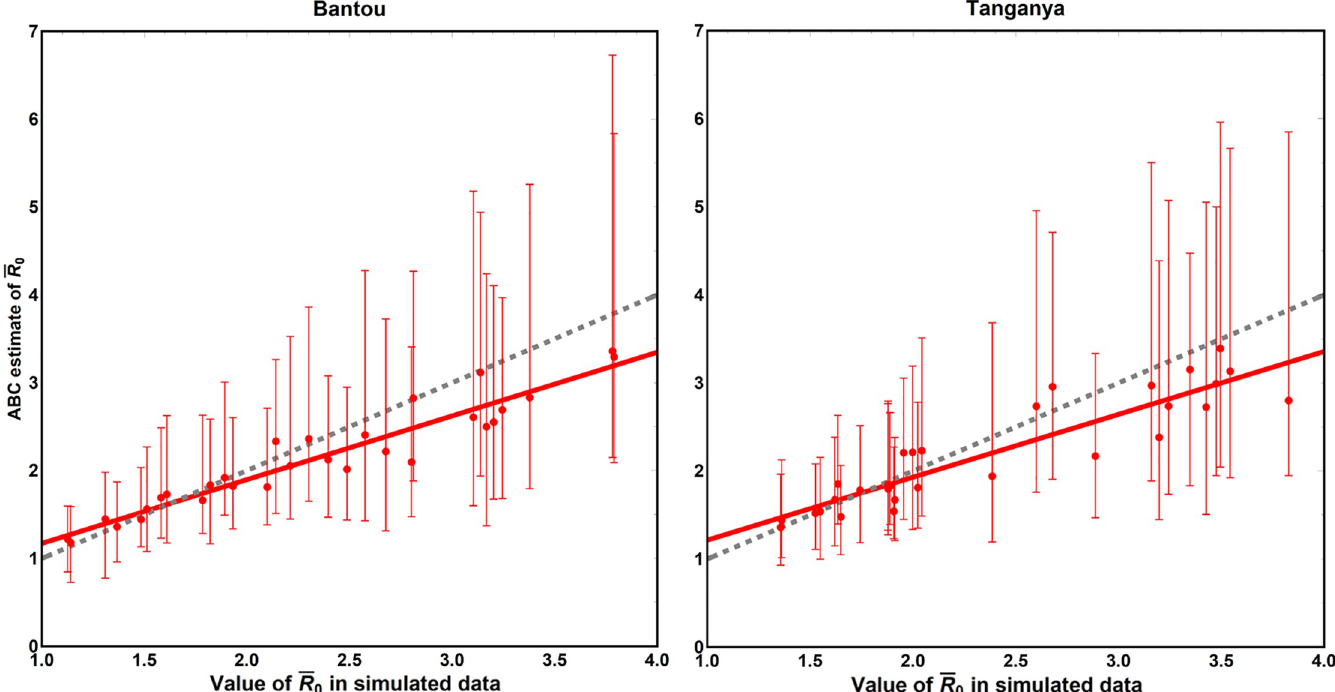
Fig 2. Comparison of time average values of R 0 in simulated data sets (x axes) and the values of time averaged R 0 estimated by our ABC approach (y-axes) when applied to the simulated data sets. The red dots indicate individual simulations, the red line the best fit to the dots, and the gray dashed line is the expected 1:1 relationship for a perfect fit. The equation for the line of best fit was given by y = 0.447+0.725x for Bantou and by y = 0.501+0.714x Tanganya where y is the value estimated by our ABC method and x is the true value in the simulated data set.